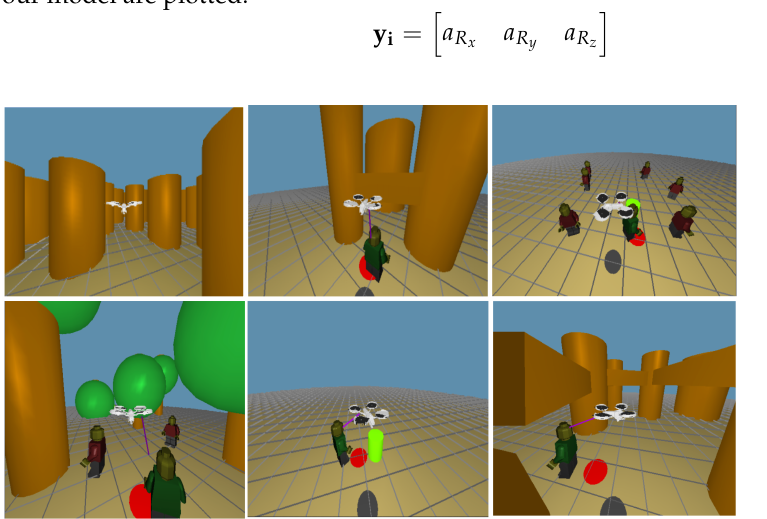
Figure 9. Simulated environments: Frames from the simulator’s view for different